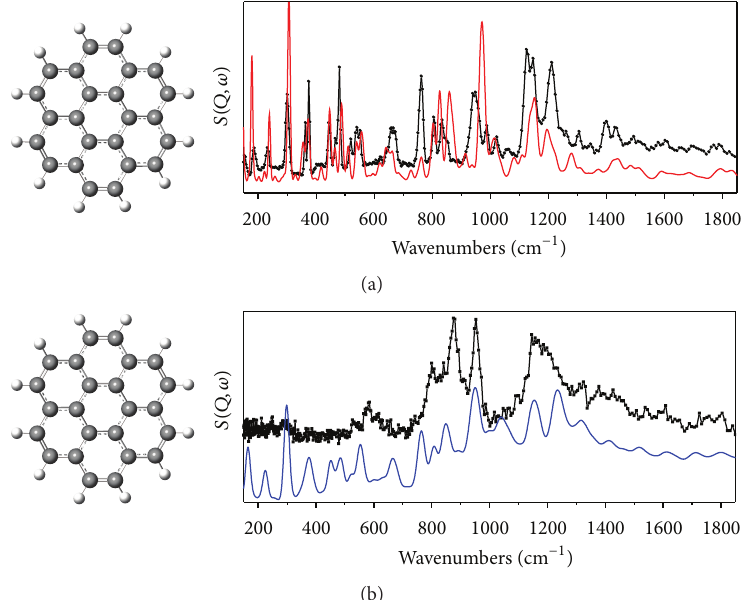
Figure 1: (a) Comparison between the experimental INS spectrum of coronene (black curve), collected by Mitchell et al. [28], and the calculated one (this work, red curve). This comparison is used to verify the level of precision of the simulations. (b) Comparison between the experimental INS spectrum of CW (dotted curve) and the calculated one (blue curve) considering isotropic phonon tails and a larger instrumental resolution to mimic structural disorder. The calculated spectrum has been vertically shifted for